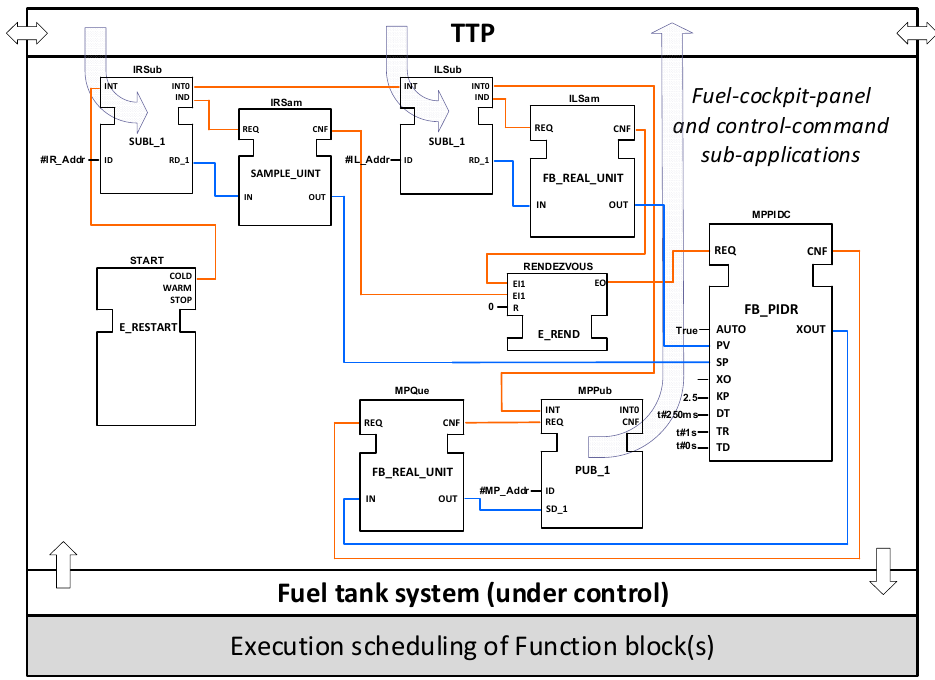
Figure 12. Reassure II.A from CPIOM-Control device: resource configuration for scenario 2.